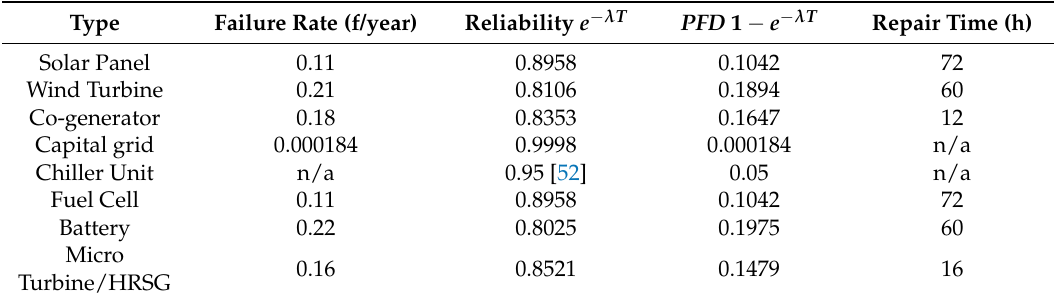
Figure 4. Fault tree analysis of MEG blackout top event hazard. Table 6. Failure rate and repair time [51].